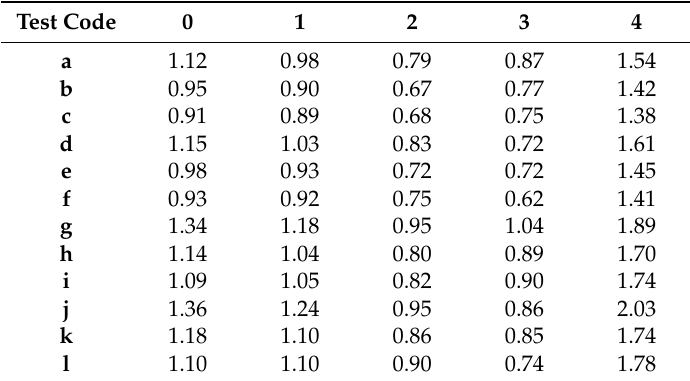
Table 6. Ra value, in microns, after the different LP tests.